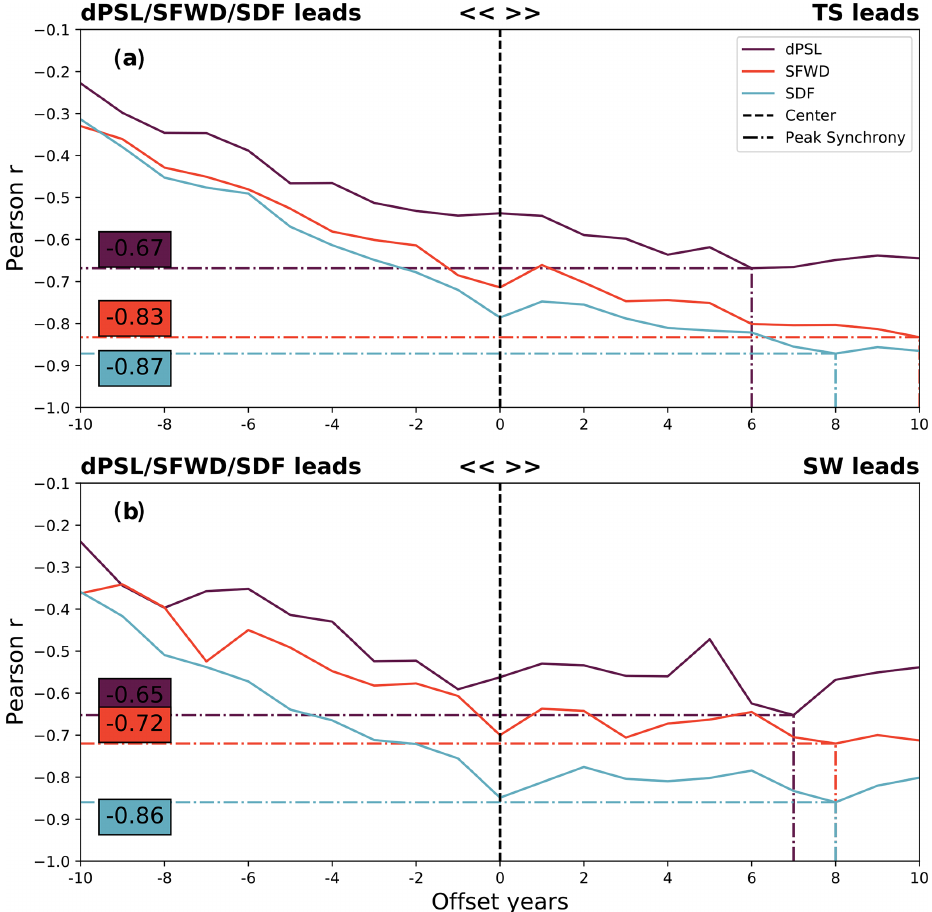
Figure 3. The 1950–2020 lead–lag atmospheric circulation correlations based on the ensemble mean annual mean all forcing Coupled Model Intercomparison Project phase 6: the subpolar North Atlantic (a) surface temperature (TS) and (b) net downward surface shortwave radiation (SW) vs. sea level pressure gradient (dPSL; purple), surface wind (SFWD; red), and surface density flux (SDF; cyan). The maximum correlations are denoted by the horizontal dashed lines and as text in the color-coded boxes, all of which are significant at the 95% confidence level. The corresponding offsets in years are denoted by the vertical dashed color-coded